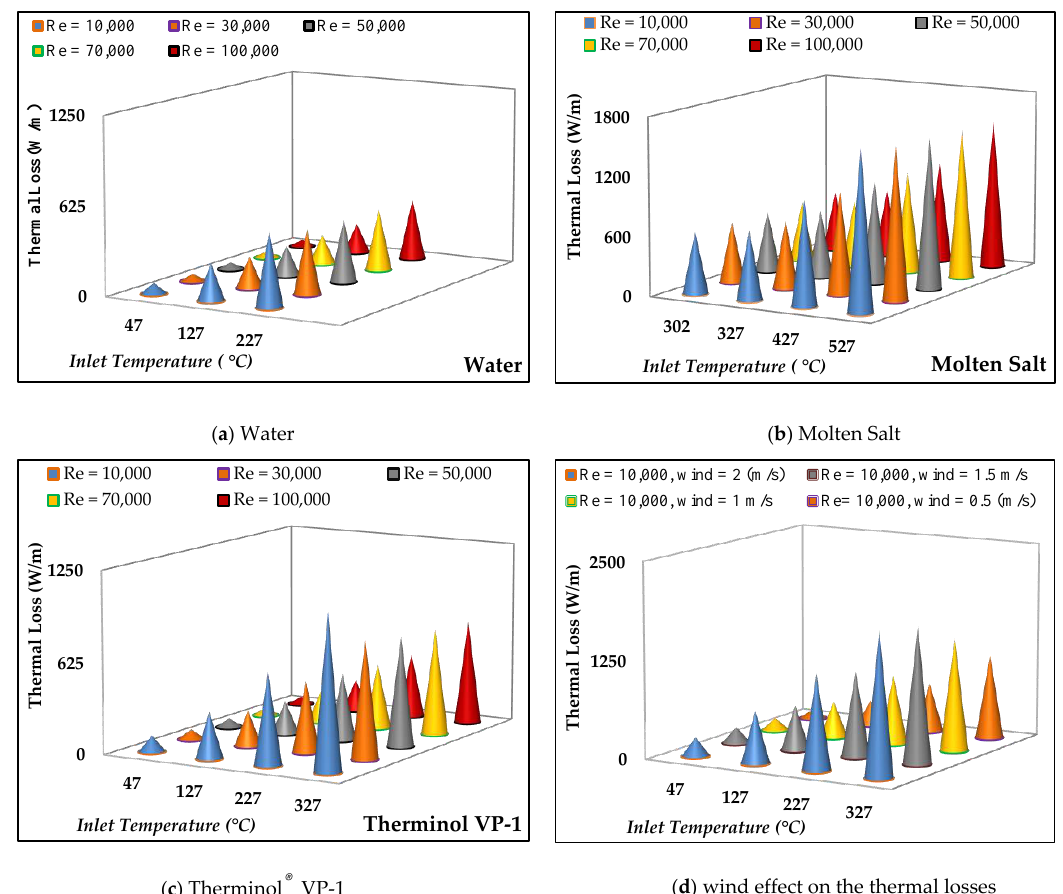
Figure 9. Thermal losses behaviour of all fluids used in this study.